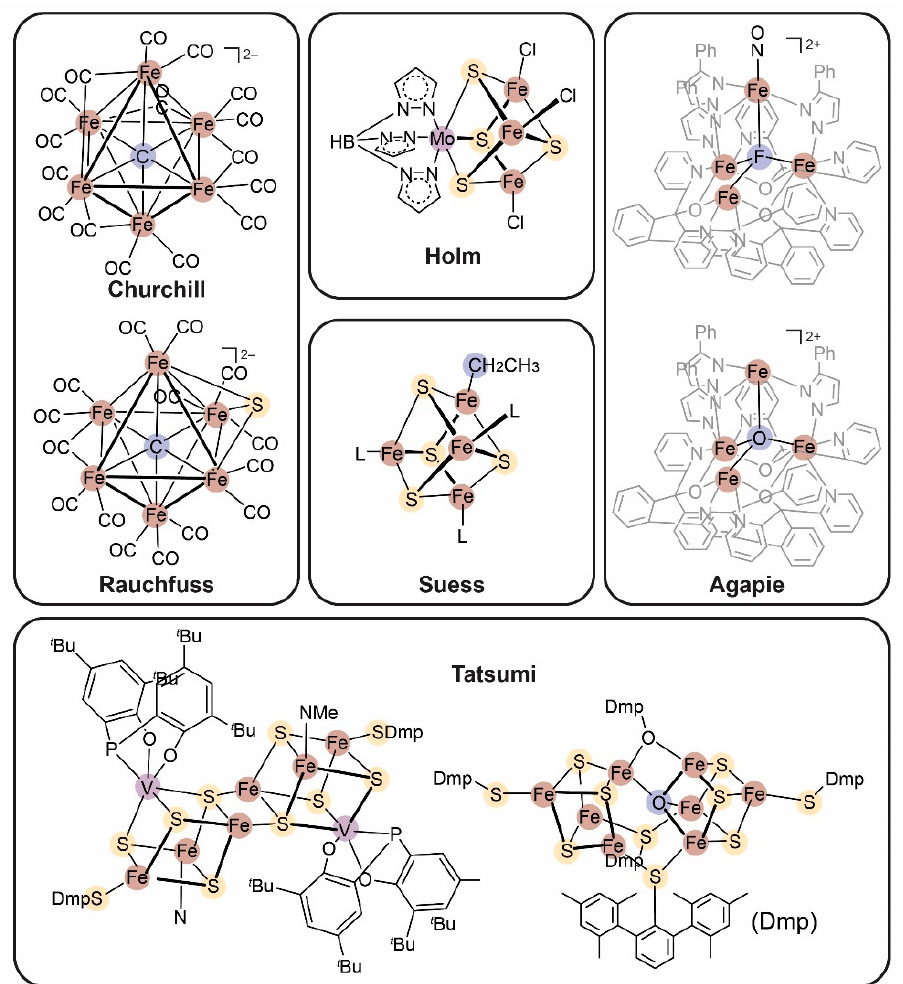
Figure 4. Selected synthetic structural models for the nitrogenase active site, including works published by the Holm, Agapie, Tatsumi, and Rauchfuss [37,38,40–49].